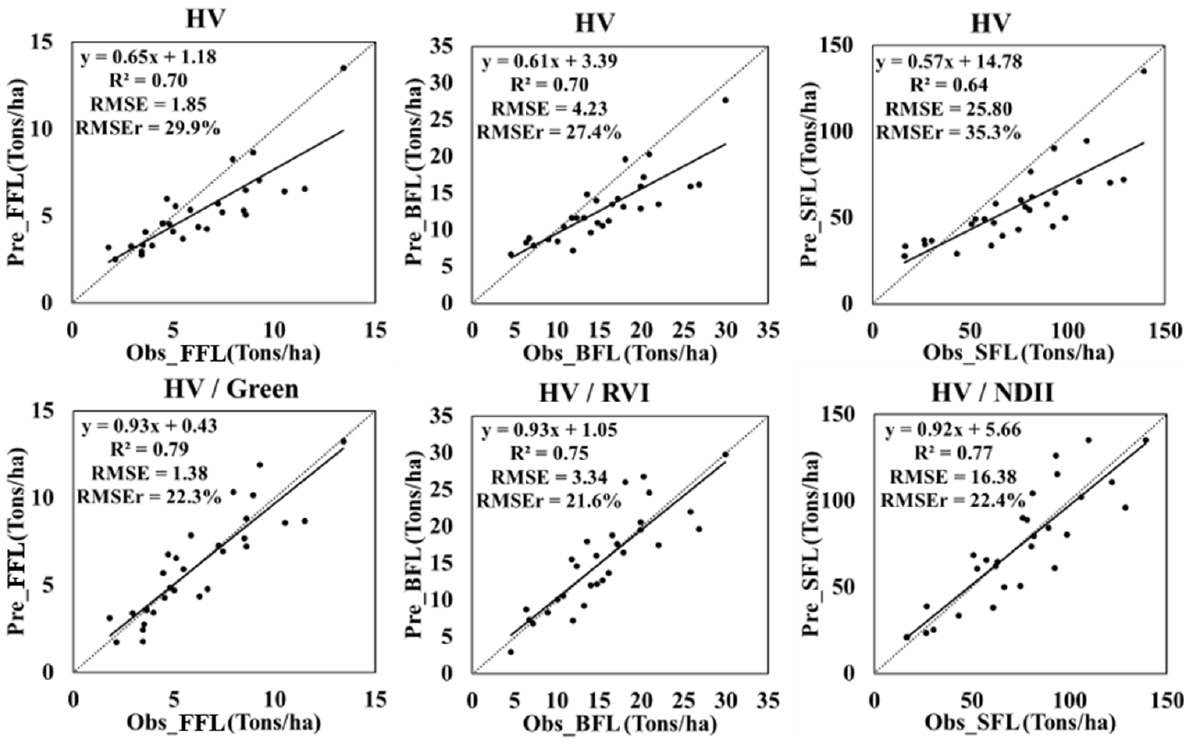
Figure 3. Comparison of FL AGL (FFL, BFL and SFL) inversion results using WCM ( top row ) and the new model ( bottom row ) on BioSAR ‐ 2008.